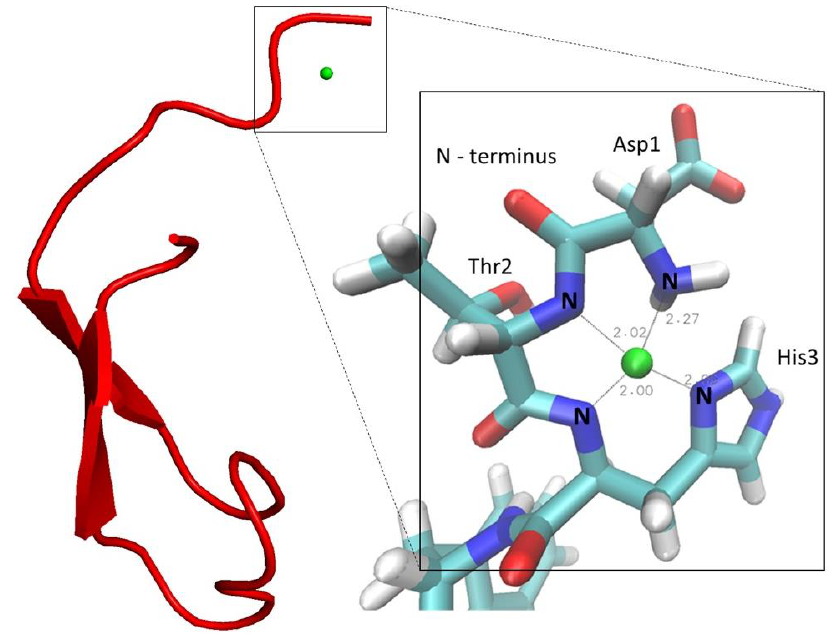
Figure 5. The lowest energy structure of the Cu 2+ -hepcidin-25 model (copper ion in